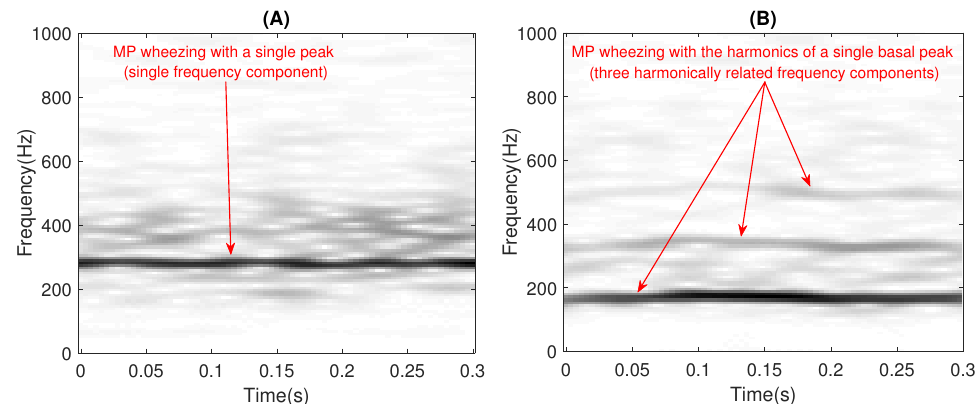
Figure 1. Time-frequency representation of two examples of Monophonic (MP) wheezing: ( A ) with a single basal peak; ( B ) with the harmonics of a single basal peak. Note that the frequency components are harmonically related in ( B ).